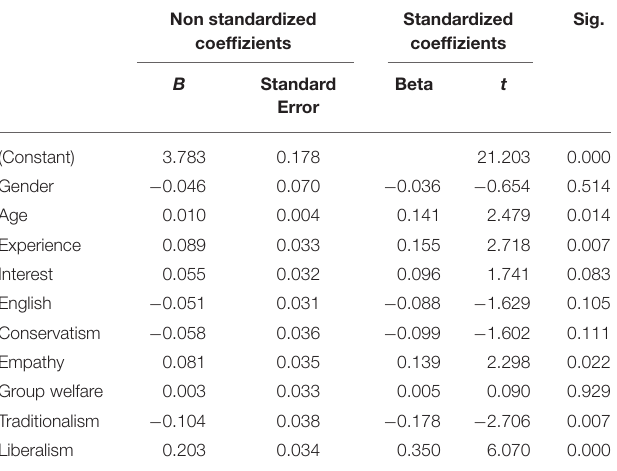
TABLE 2 | Linear regression model predicting the score on the UN-scale in the Austrian sample.